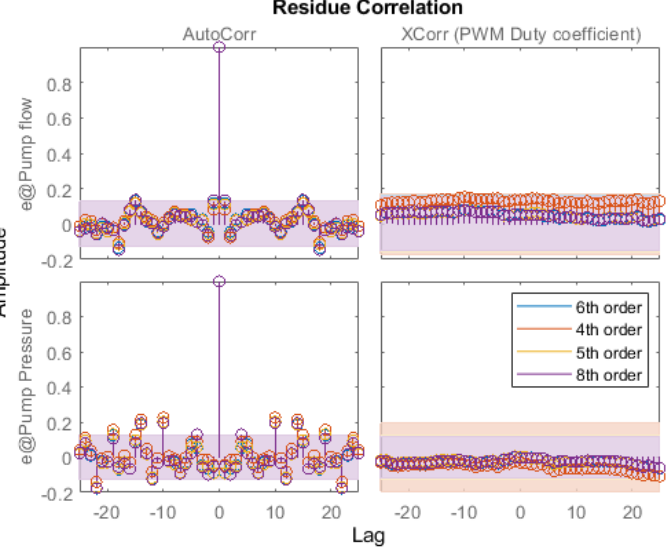
Figure 10. Residual correlation test of 6th order model.